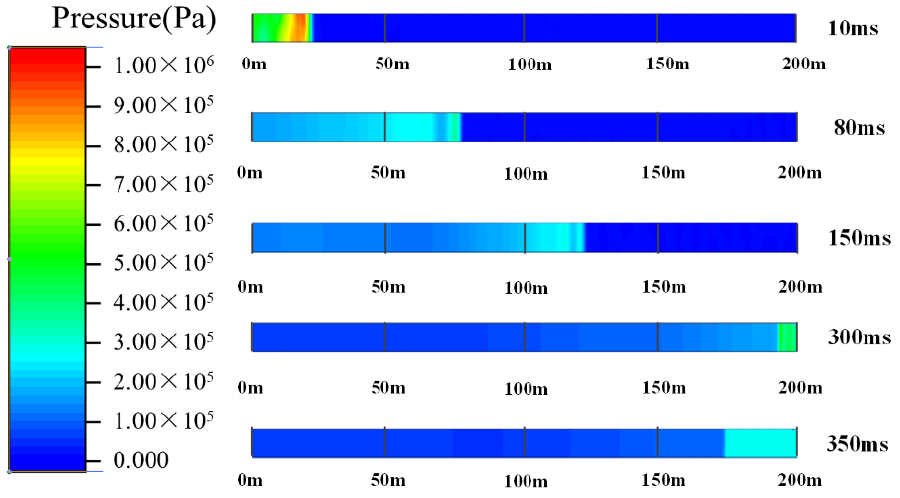
Figure 10. Contour diagram of overpressure change diagram of gas cabin without gas baffle.